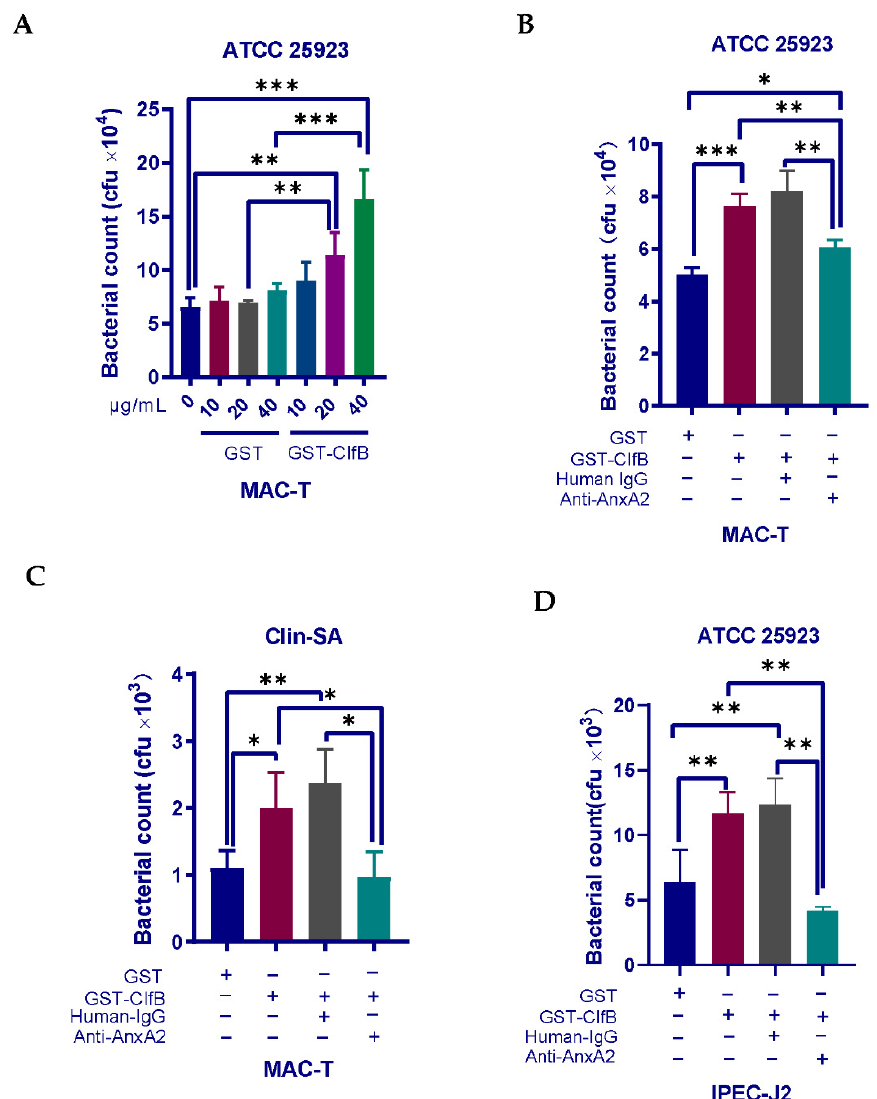
Figure 6. Interaction of ClfB and AnxA2 is required for S. aureus invasion. (A) Recombinant ClfB enhances S. aureus invasion in a dose-dependent manner. MAC-T cells in 24-well plates were pretreated with recombinant or GST-tagged ClfB (0–40 µ g/mL) for 1 h, followed by co-incubation with S. aureus ATCC 25923 at an MOI of 25 for another 1 h. ( B – D ) Anti-AnxA2 blocks recombinant ClfB –induced S. aureus internalization. MAC-T (B and C) or IPEC-J2 ( D ) were treated with anti-AnxA2 antibody (17.5 µ g/mL) or human IgG (17.5 µ g/mL) for 2 h prior to exposure to GST-tagged recombinant ClfB (20 µ g/mL) for 1 h. After washing in DPBS 3 times, cells were co-cultured with S. aureus ATCC 25923 (B and D) at an MOI of 25 or clinical isolate of S. aureus (Clin-SA) ( C ) at an MOI of 50 for 1 h. Cells treated with recombinant GST (20 µ g/mL) or GST-tagged recombinant ClfB (20 µ g/mL) alone were served as controls. Bacterial invasion was determined by gentamicin protection assays. The graph shows mean values ± s.d. of three replicates. * P < 0.05; ** P < 0.01; and *** P < 0.001.